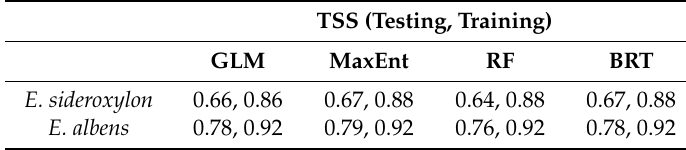
Table 1. TSS value (testing, training) for E. sideroxylon and E. albens for four different